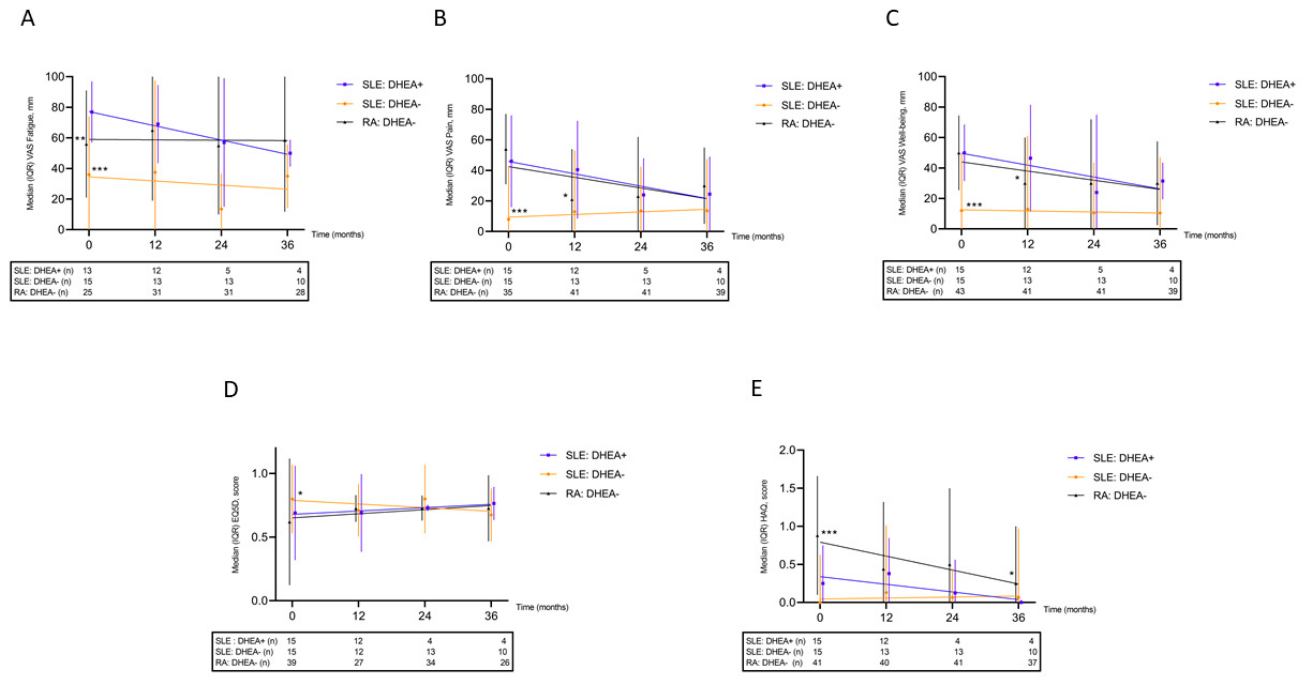
Figure 2. Longitudinal patient-reported outcome measures shown for patients with systemic lupus erythematosus (SLE) exposed/unexposed to DHEA and for sex- and age-matched controls with rheumatoid arthritis (RA); ( A ) visual analogue scale (VAS) fatigue, worse in DHEA-exposed SLE than in SLE/RA controls; ( B ) VAS pain, worse in DHEA-exposed SLE compared with SLE controls; ( C ) VAS well-being, worse in DHEA-exposed SLE compared with SLE controls; ( D ) EQ-5D, worse in DHEA-exposed SLE compared with SLE controls; ( E ) Health Assessment Questionnaire (HAQ), worse in RA compared with both SLE groups. * p < 0.05, ** p < 0.01, *** p < 0.005.